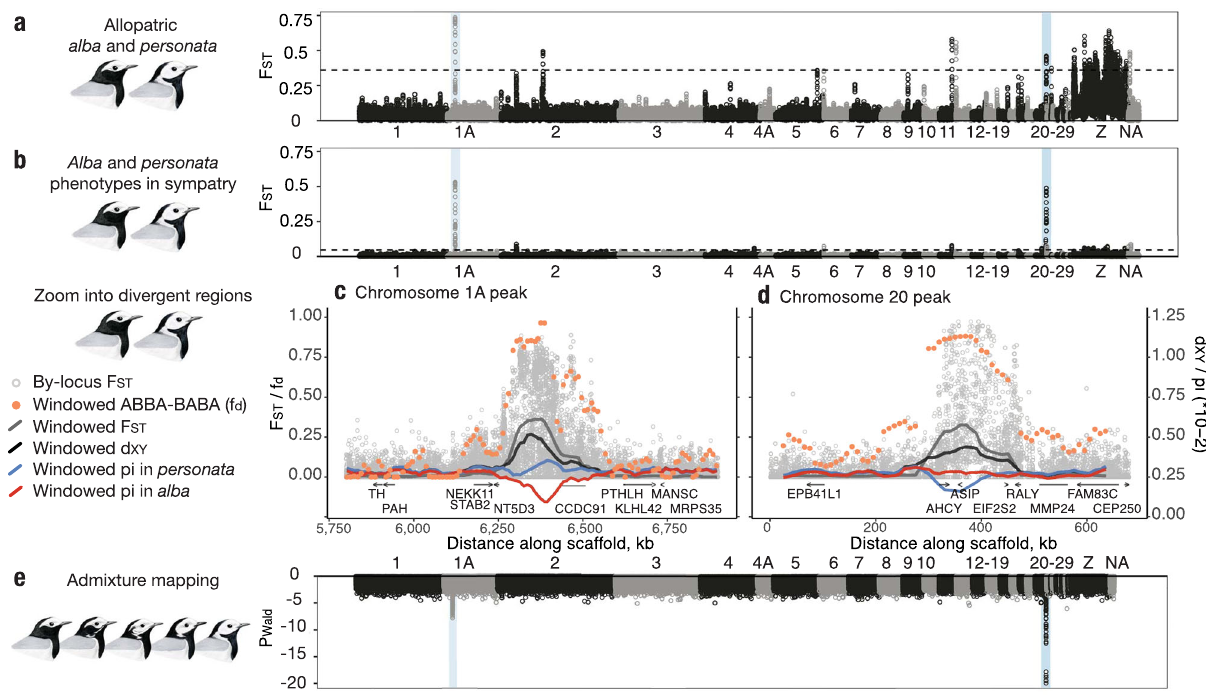
Fig. 2 Whole-genome differentiation between alba and personata subspecies and the results of admixture mapping. a , b Show relative genomic differentiation ( F ST ) between remote allopatric populations and sympatric alba and personata head plumage phenotypes, respectively, estimated in 25 kb windows with 10 kb steps. Note that among multiple regions differentiated between allopatric populations, only two peaks on chromosomes 1A and 20 (highlighted in blue) remain distinct in sympatry. c , d Expand the highlighted regions on chromosomes 1A and 20. Gray circles are by-locus Weir-and- Cockerham F ST , light gray and black lines are window-based estimates of the relative ( F ST ) and absolute ( d XY ) differentiation, respectively. Red and blue lines are window-based estimates of nucleotide diversity in alba and personata , respectively. Orange dots are window-based ABBA – BABA ( f d ) indicating a fraction of shared ancestry between sympatric and allopatric personata (50 kb windows with 10 kb steps, see the “ Methods ” section for details). Below each plot are gene models with arrows indicating the direction of reading frame where it is known. Note that the divergent peak on chromosome 1A is mostly located in a non-coding region but includes the coiled-coil domain-containing protein 91 ( CCDC91 ) gene. The peak on chromosome 20 overlaps three genes: adenosylhomocysteinase ( AHCY ), eukaryotic translation initiation factor 2 subunit beta ( EIF2S2 ), and is centered around agouti signaling protein ( ASIP ). e Results of admixture mapping for head plumage. Each dot is a − log 10 -transformed P -value for rejecting a model assuming no association between variation in a trait and a genetic locus. Dashed lines on a and b are 0.995